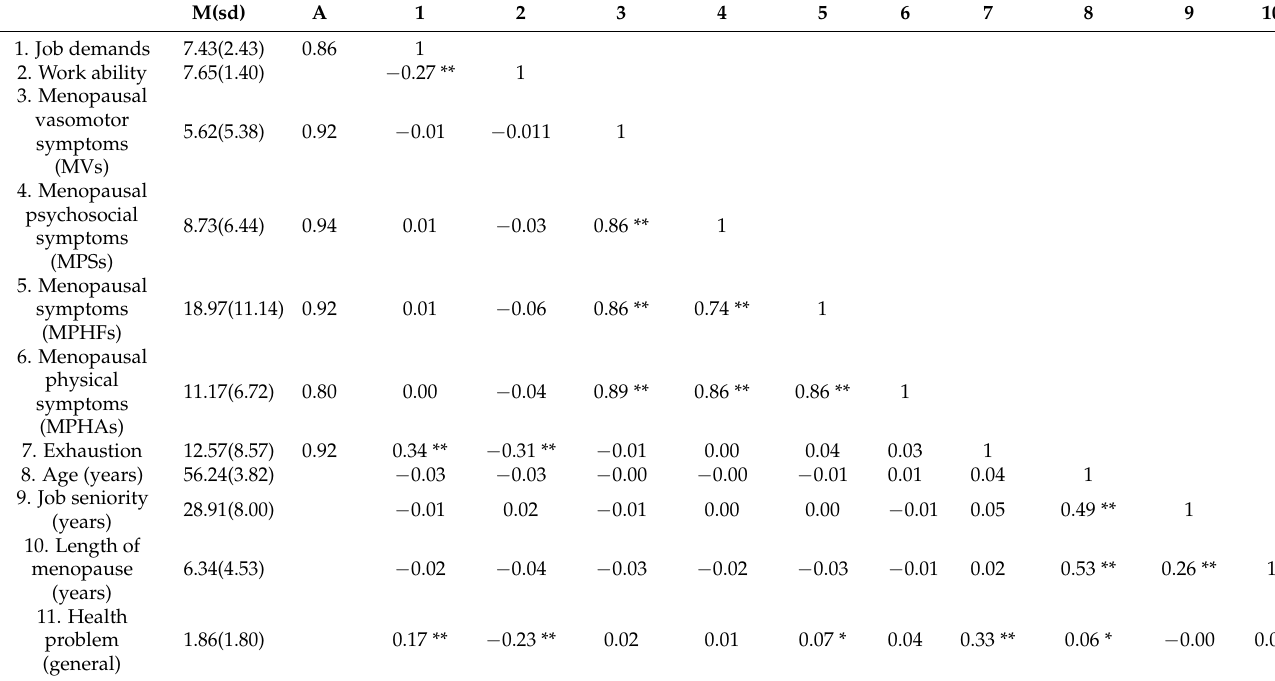
Table 2. Descriptive analyses and Pearson’s